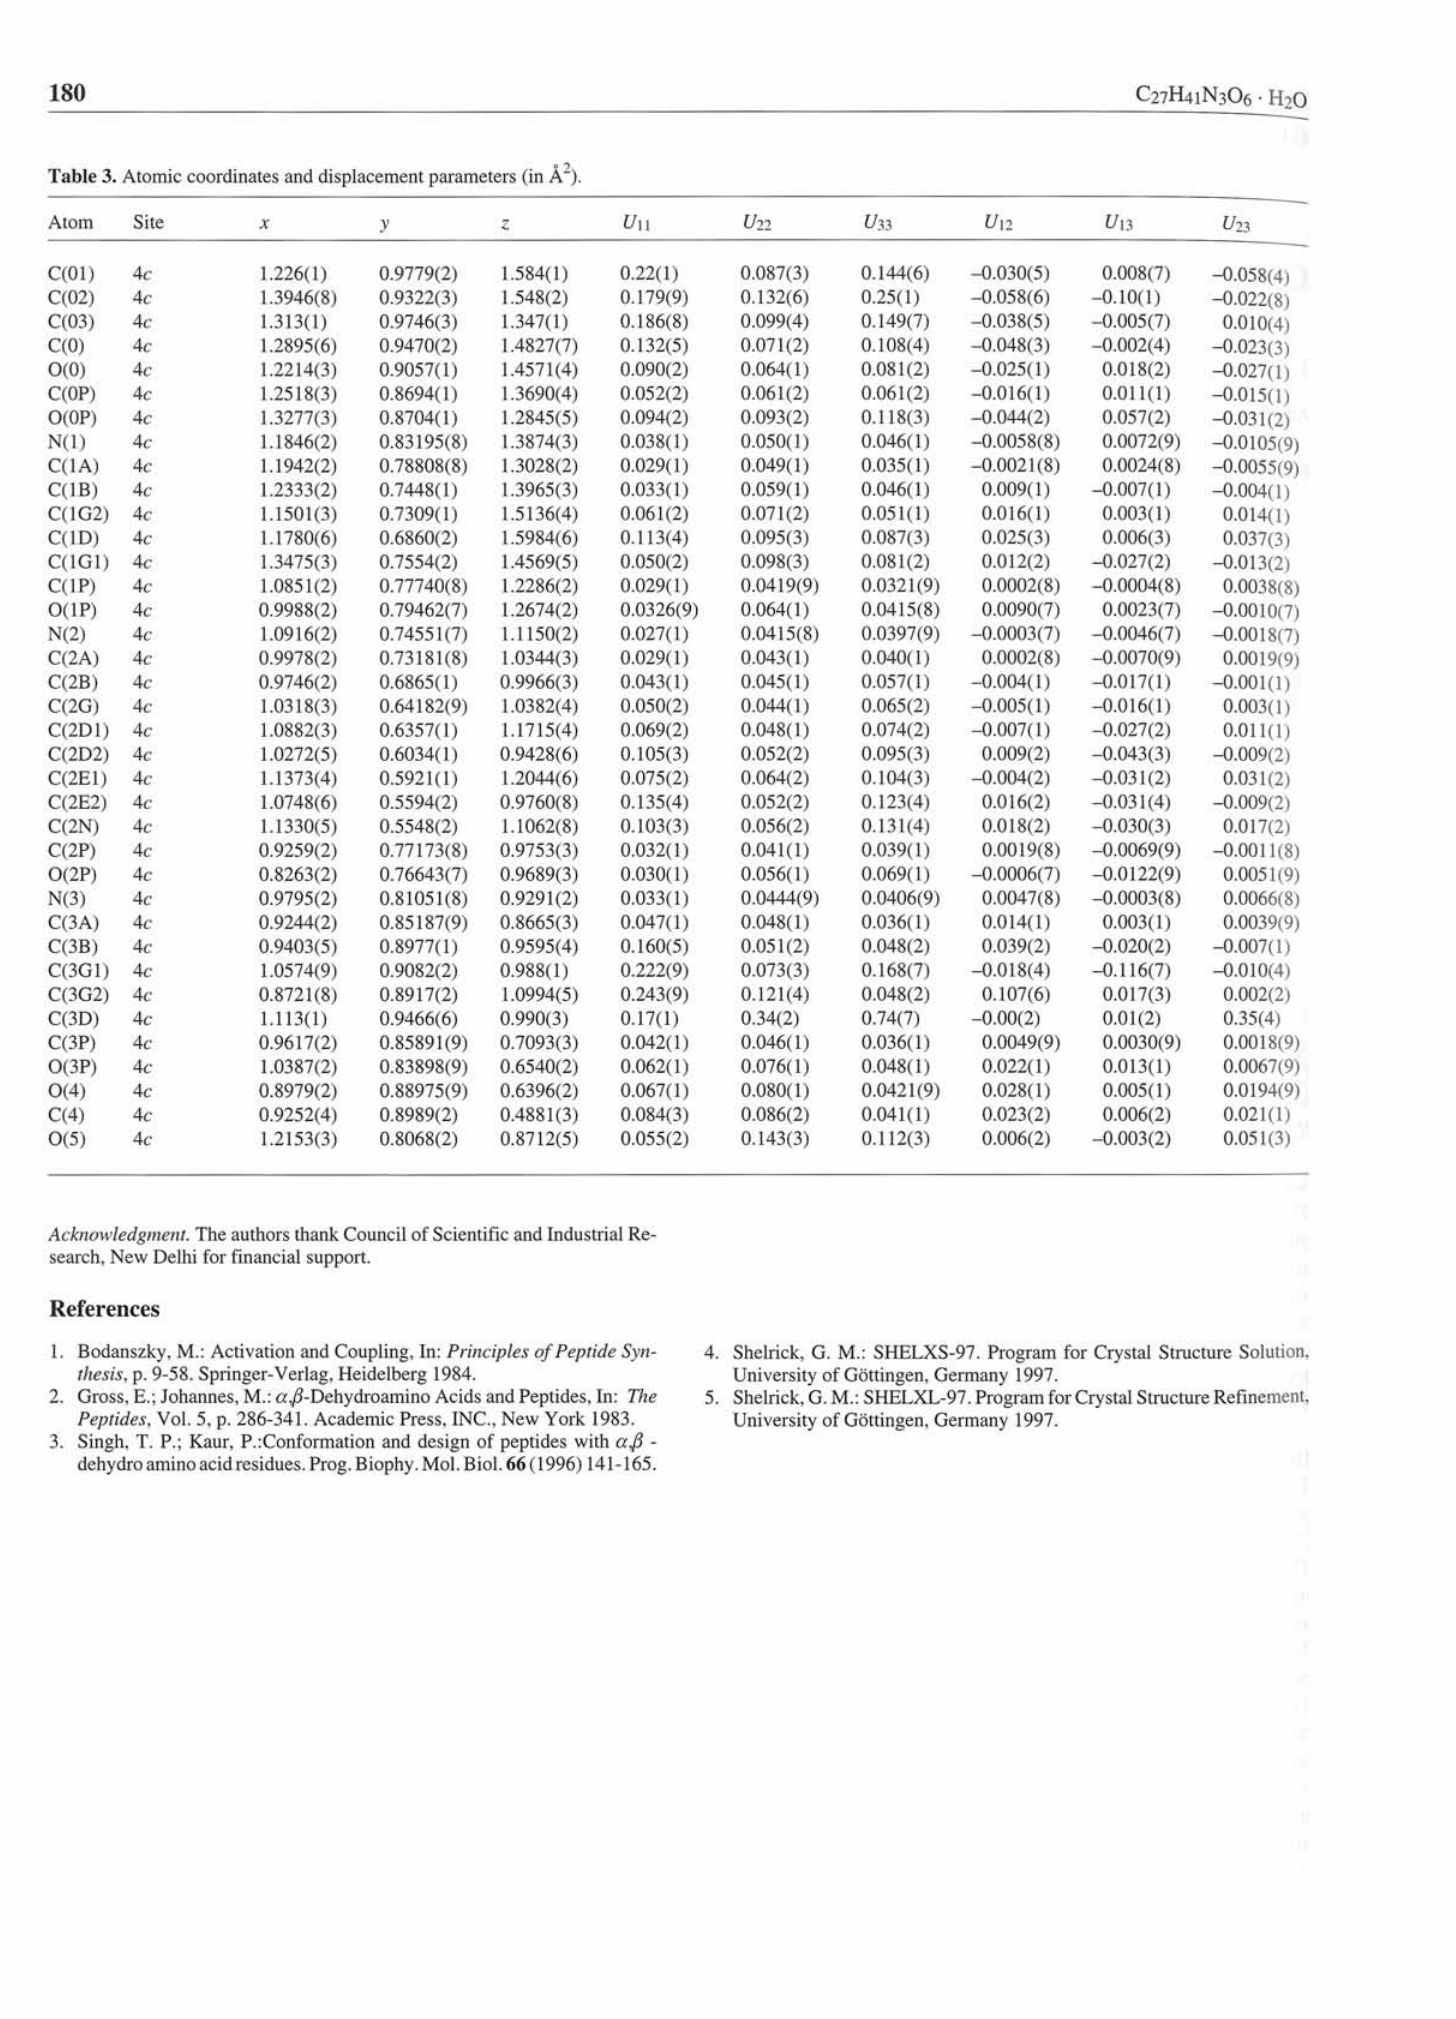
Table 3. Atomic coordinates and displacement parameters (in Â 2